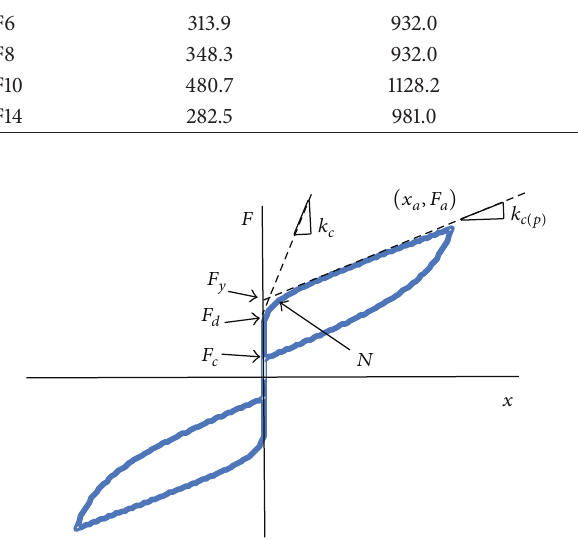
Figure 2: Hysteretic behaviour of the